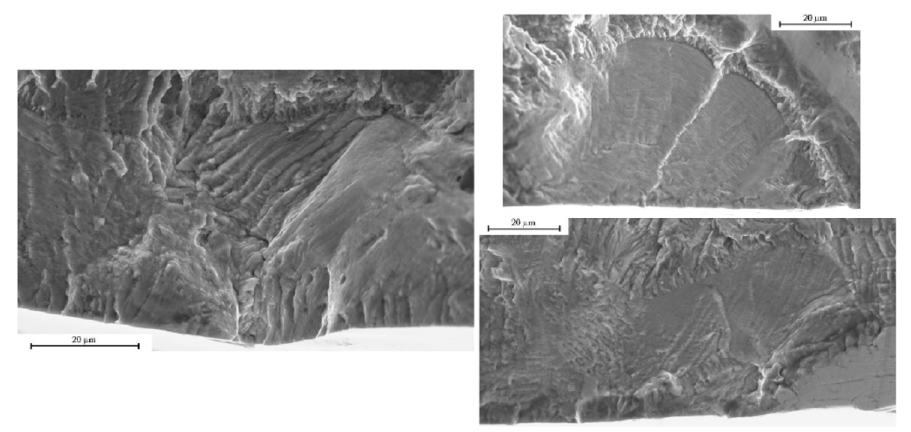
Figure 6. Crack depth as a function of the number of cycles derived from interrupted tests for different loading conditions, namely, triangular signals with different strain rates, SIS A, and SIS B signals in air.